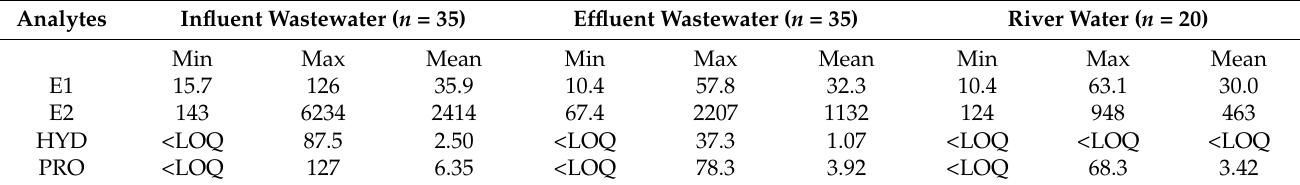
Table 5. Minimum (min), maximum (max) and mean concentration (ng L − 1 ) of four steroid hor- mones in influent wastewater, effluent wastewater and river water samples: n = number of samples containing detectable amounts of target